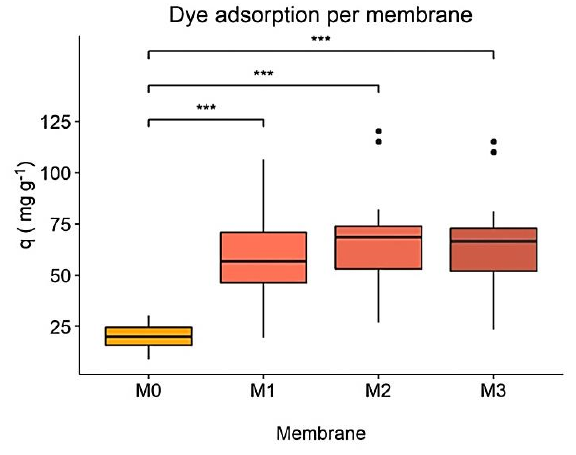
Figure 5. Dye adsorption capacity ( q ) per membrane. Statistical significance between membranes at equal time points is indicated by *, with * p < 0.05, ** p < 0.001 and *** p < 0.0001